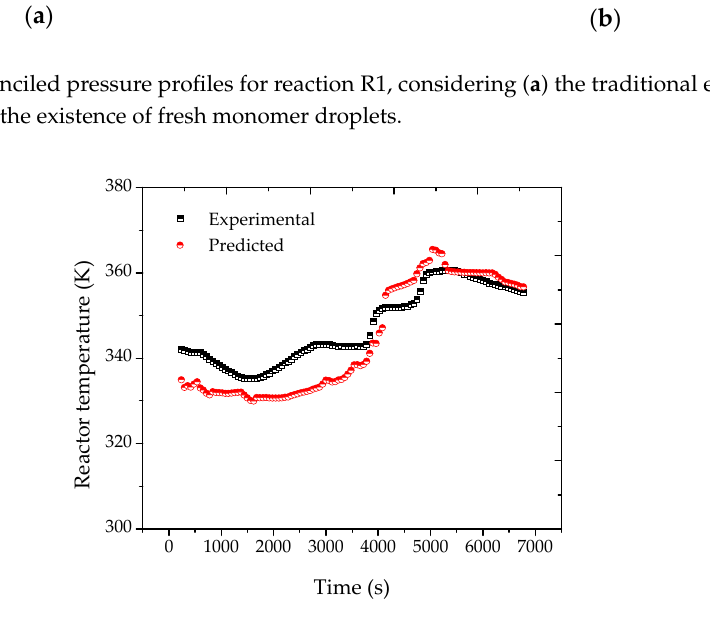
Figure 5. Reconciled reactor temperature profiles for reaction R2 considering the traditional equilibrium approach.